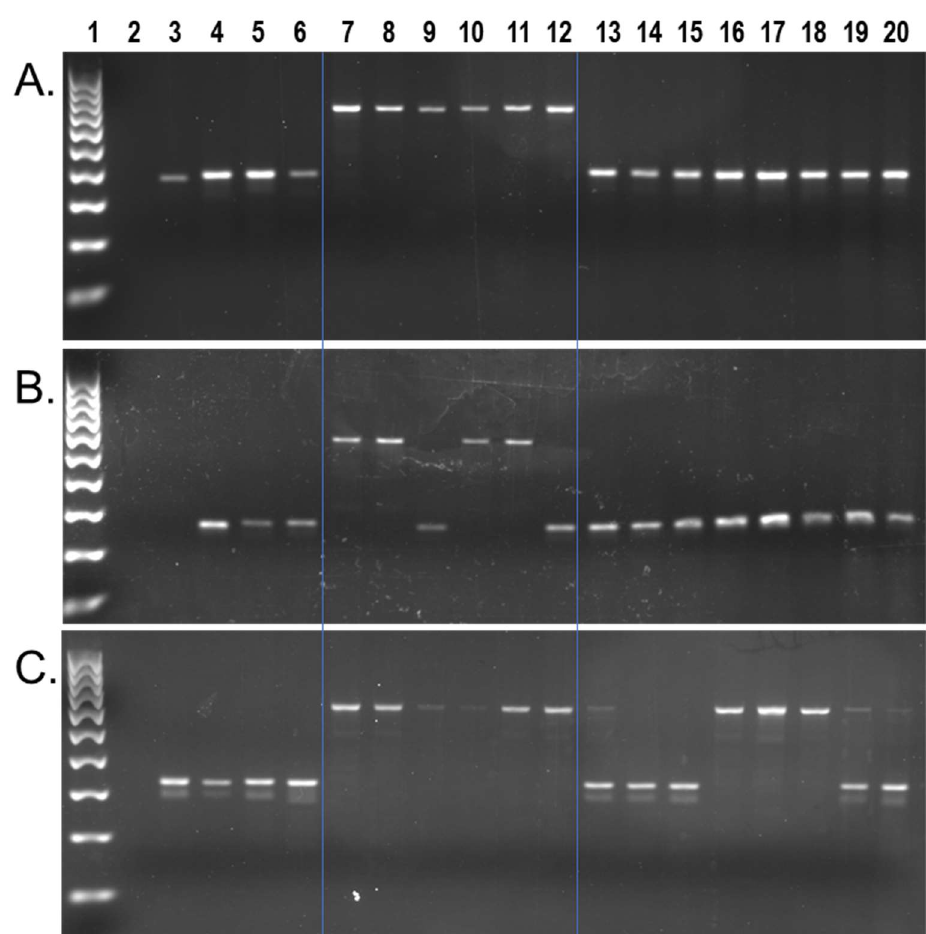
Figure 2. C. imitator genomic Alu insertion polymorphisms. Lanes: 1 100 bp DNA ladder, 2 TLE (negative control), 3 Human (HeLa), 4 Callithrix jacchus (Common marmoset), 5 Saimiri s. sciureus (Common squirrel monkey), 6 Aotus trivirgatus (Three striped owl monkey), 7 C. imitator , 8–9 C. capucinus , 10–11 C. albifrons , 12 C. a. albifrons , 13–20 S. apella . ( A ) Locus #69, Alu is present in all Cebus species individuals (~693 bp DNA fragment lanes 7–12) and absent in all Sapajus samples (~381 bp DNA fragment lanes 13–20); ( B ) Locus #49, Alu is polymorphic among Cebus individuals (~580 bp fragment present, ~275 bp fragment absent) and absent in all Sapajus samples; ( C ) Locus #9, Alu is present in Cebus individuals (~653 bp fragment) and polymorphic among Sapajus individuals (~653 bp, and ~340 bp DNA fragments). Blue lines superimposed on gel images visually separate Cebus , Sapajus, and outgroups.